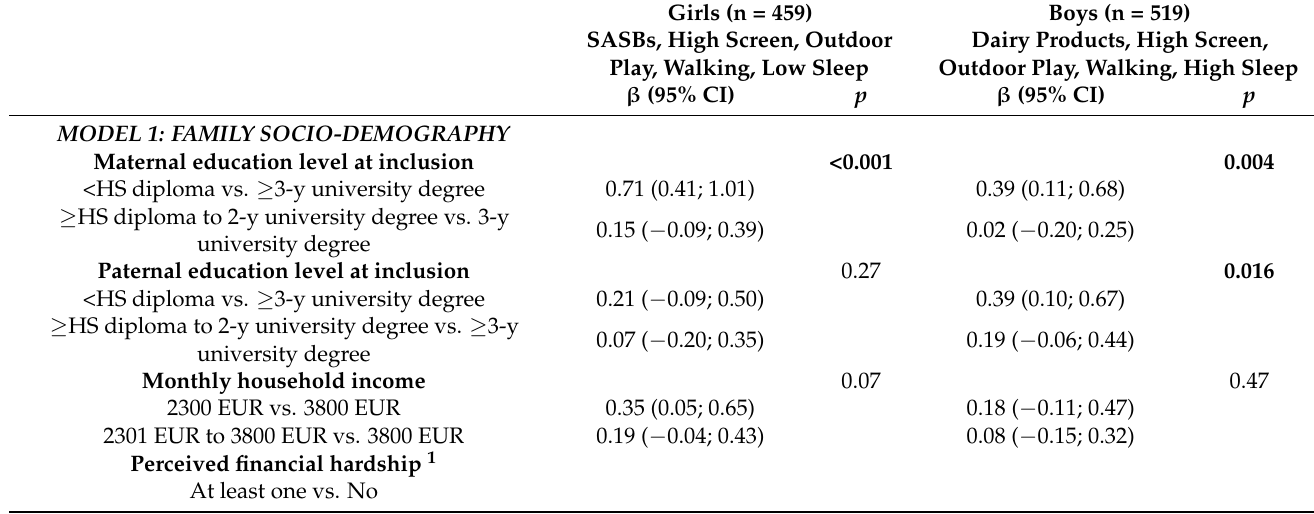
Table 5. Betas (95% CI) from multiply imputed and weighted hierarchical multivariable linear regression analyses, stratified by sex with mixed lifestyle pattern as the dependent variables. The EDEN